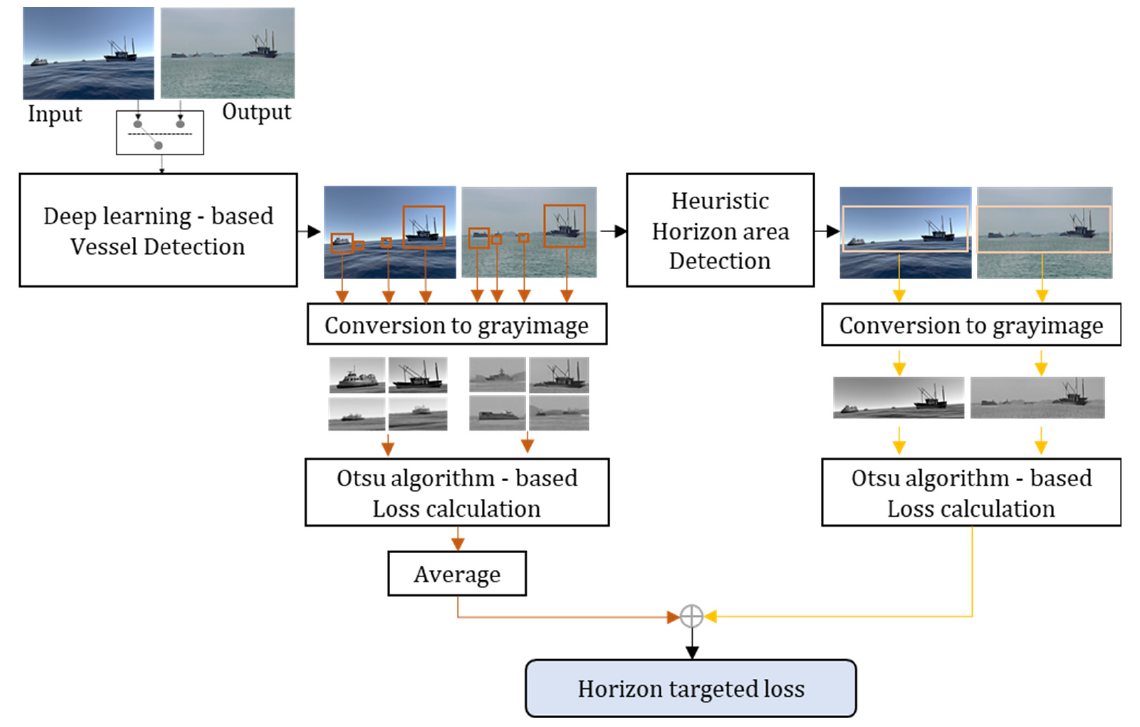
Figure 5. Flowchart depicting horizon-targeted loss calculation process.